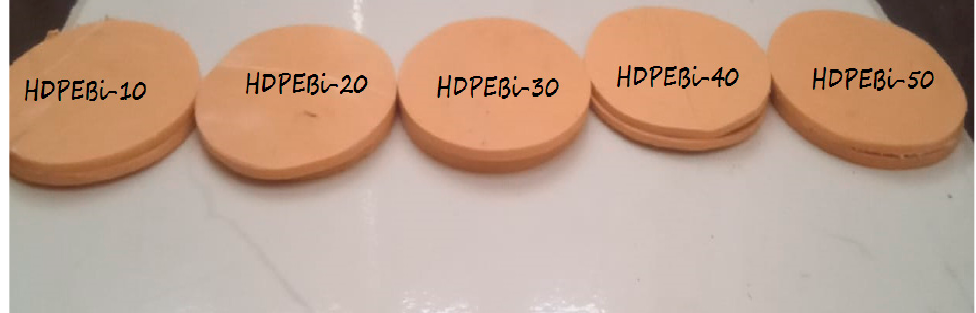
Figure 1. Picture of prepared bismuth oxide containing high-density polyethylene.